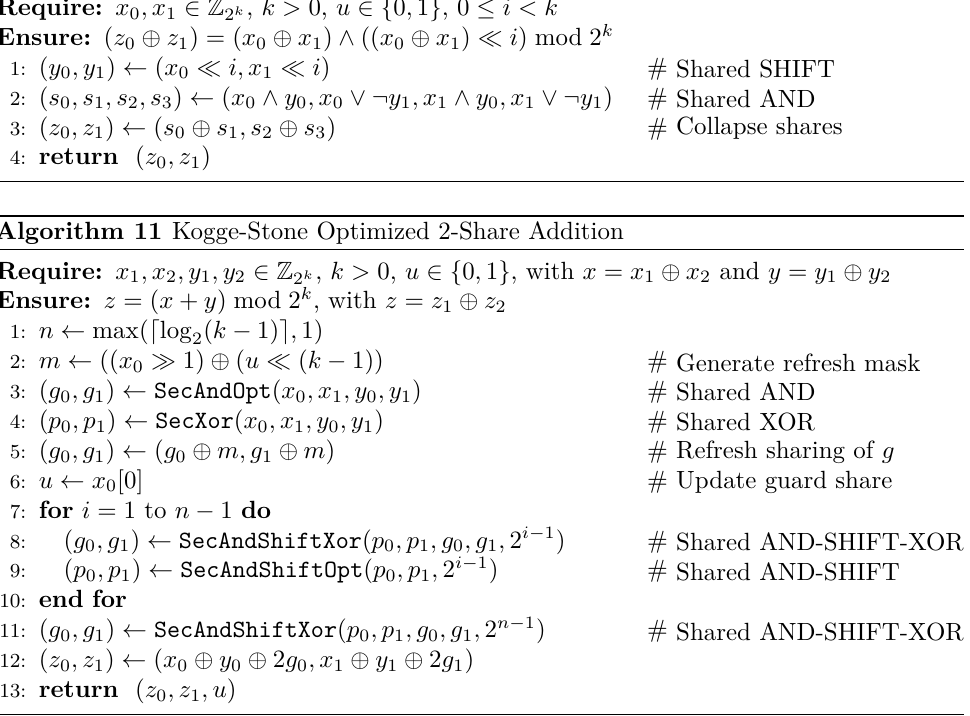
Algorithm 10 Optimized 2-Share TI of a k -radix AND-SHIFT gate ( SecAndShiftOpt ) [BDLCU17].